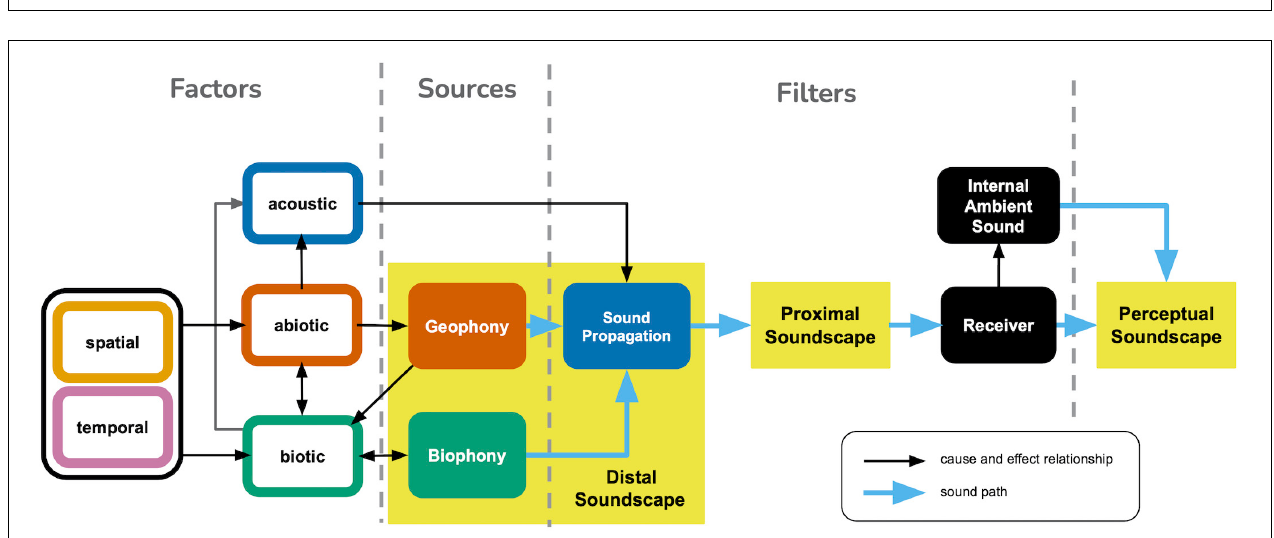
FIGURE 4 | Detailed soundscape functional block diagram: focus on sound propagation.